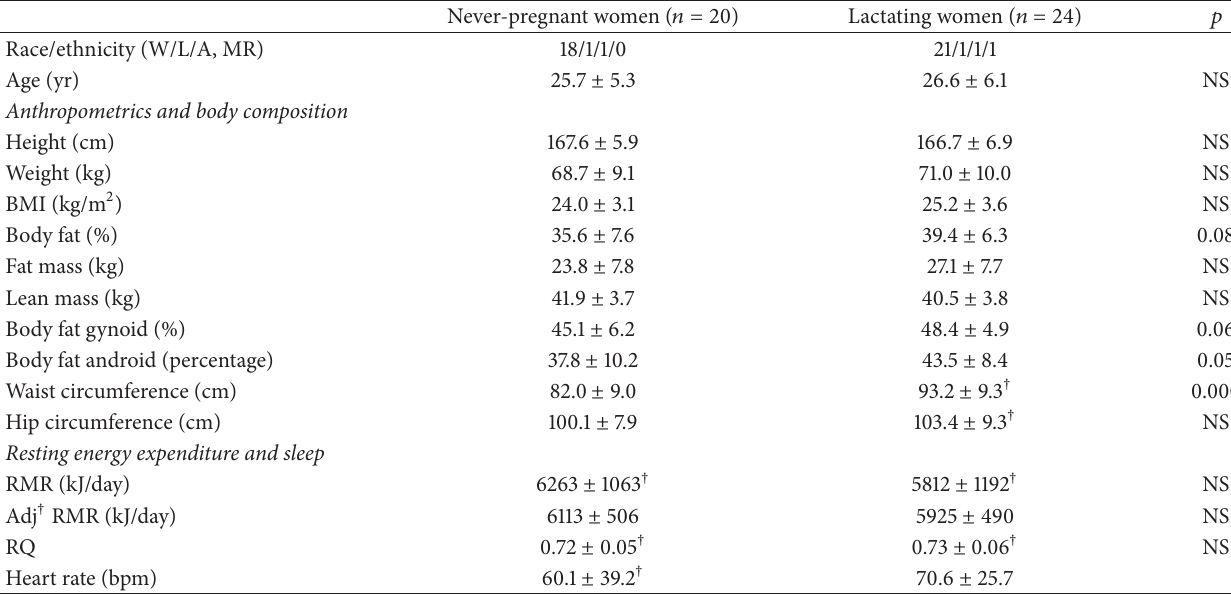
Table 1: Physical and anthropometric characteristics and resting metabolism in postpartum lactating and never-pregnant control women. Never-pregnant women ( 𝑛 = 20 ) Lactating women ( 𝑛 = 24 ) Race/ethnicity (W/L/A, MR) Anthropometrics and body